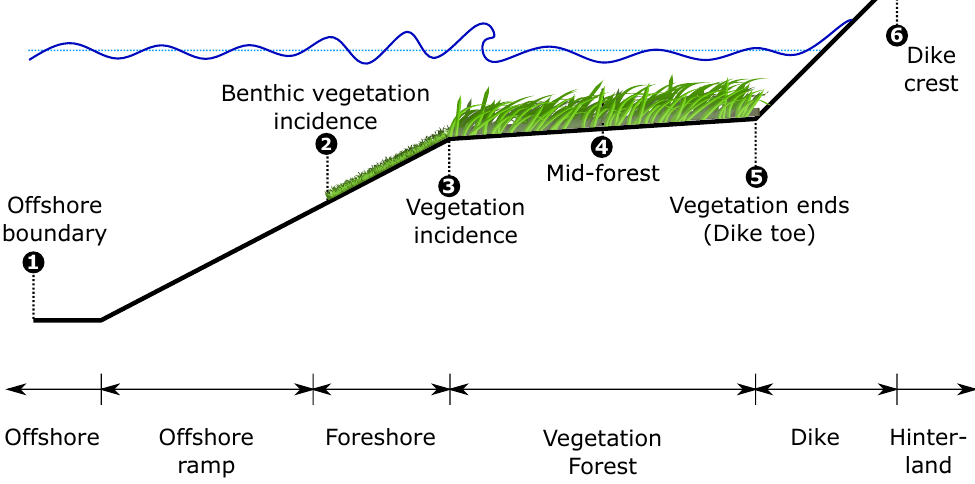
Figure 3. Idealized profile used for stochastic modeling including six segments with distinct hydro- dynamic and vegetation